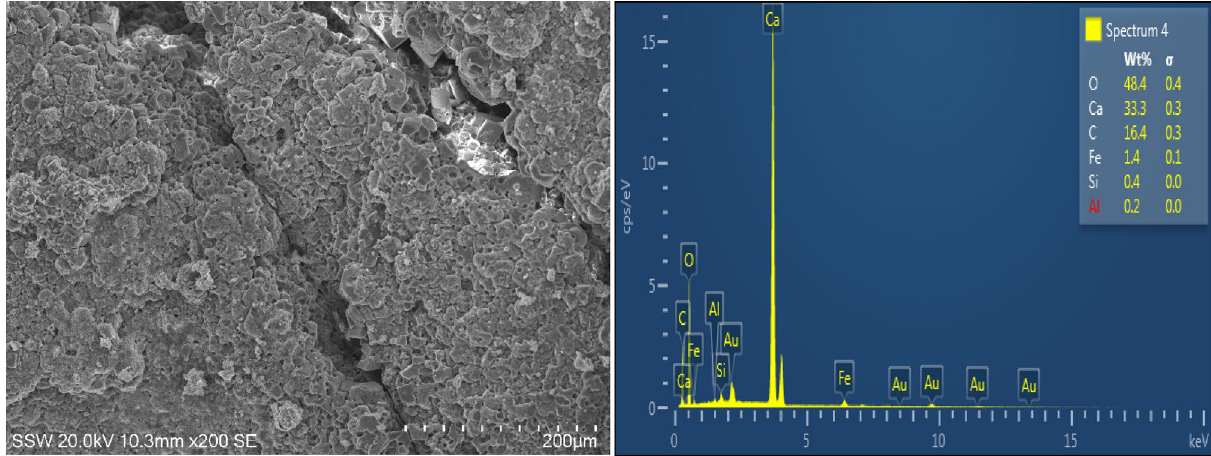
Figure 10. SEM images with energy disperse X-ray pattern of compounds in self-healed cracks for FA20 specimens.